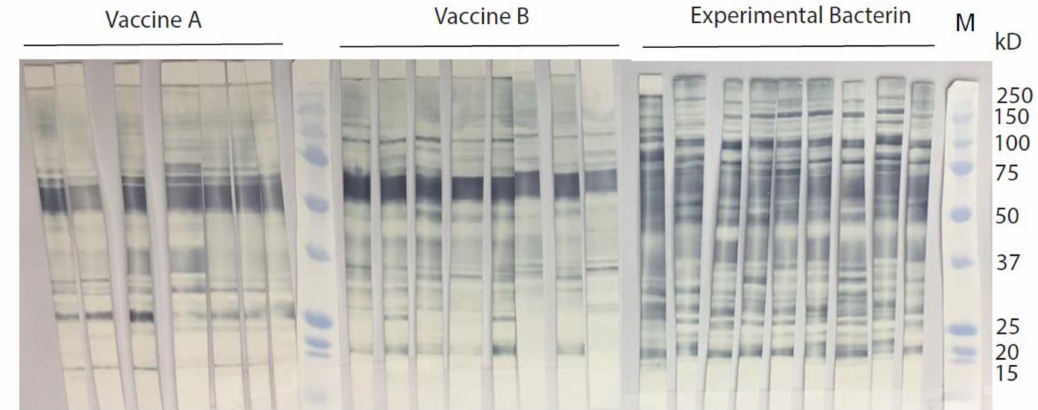
ELISA. Pre-vaccination sera (pre) and post-vaccination sera (post, 2 weeks after the last dose) for each group are plotted side by side. Each symbol represents the optical density (OD) value of a single animal. The bars represent the mean OD values of the groups. The mean ELISA OD values for post-vaccination sera immunized by vaccine A, vaccine B, and the experimental bacterin are significantly greater than those from the sham group and those from the pre-vaccination sera in each group (* p < 0.05).